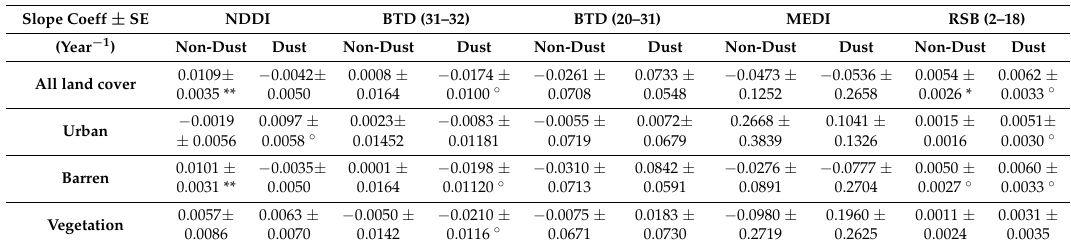
Table 3. Slope Coefficient Values of the Temporal Linear Regression Analysis with Associated Uncertainty Value (and Level of